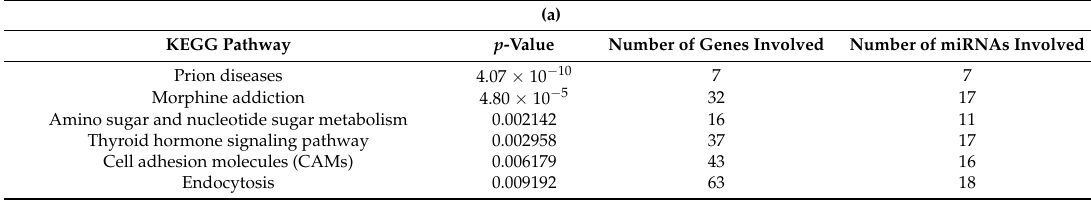
Table 2. Selected KEGG biological pathways potentially affected by ( a ) miRNAs down-regulated; and ( b ) miRNAs up-regulated in the presence of vitamin C in human bone marrow stromal cells. ( a ) KEGG Pathway p -Value Number of Genes